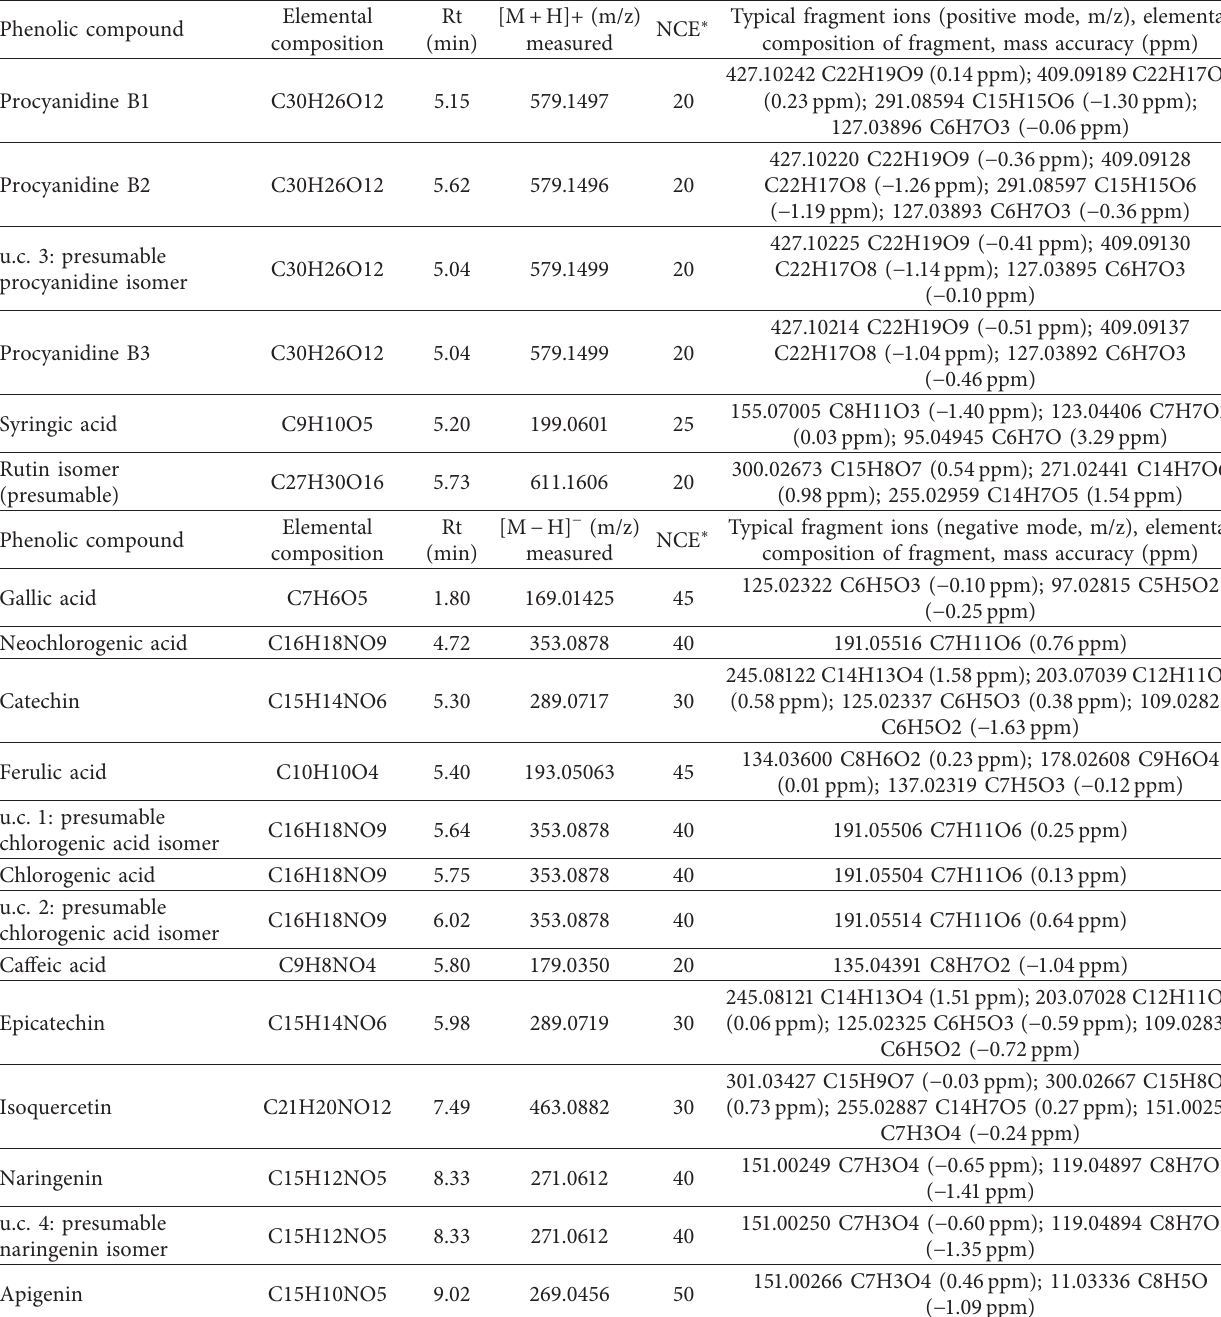
Table 1: Mass spectrometric data (positive and negative ionization) for phenolic compounds detected in Salacca zalacca fruit pulp by UHPLC-HRMS/MS